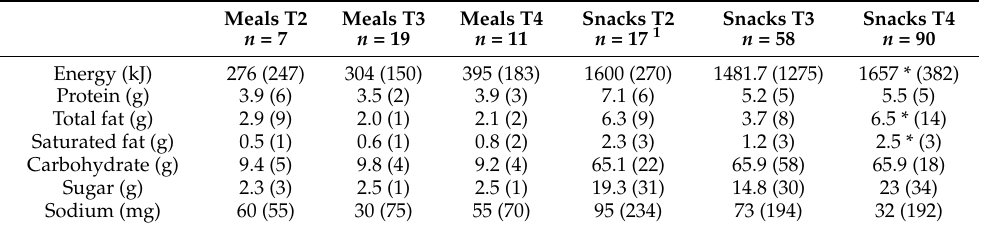
Table 2. Median nutrient values/100 g and (interquartile range) of meals and snacks launched in time-periods 2, 3, and